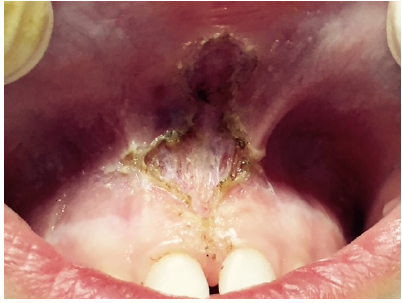
Figure 6. ULF laser surgery.